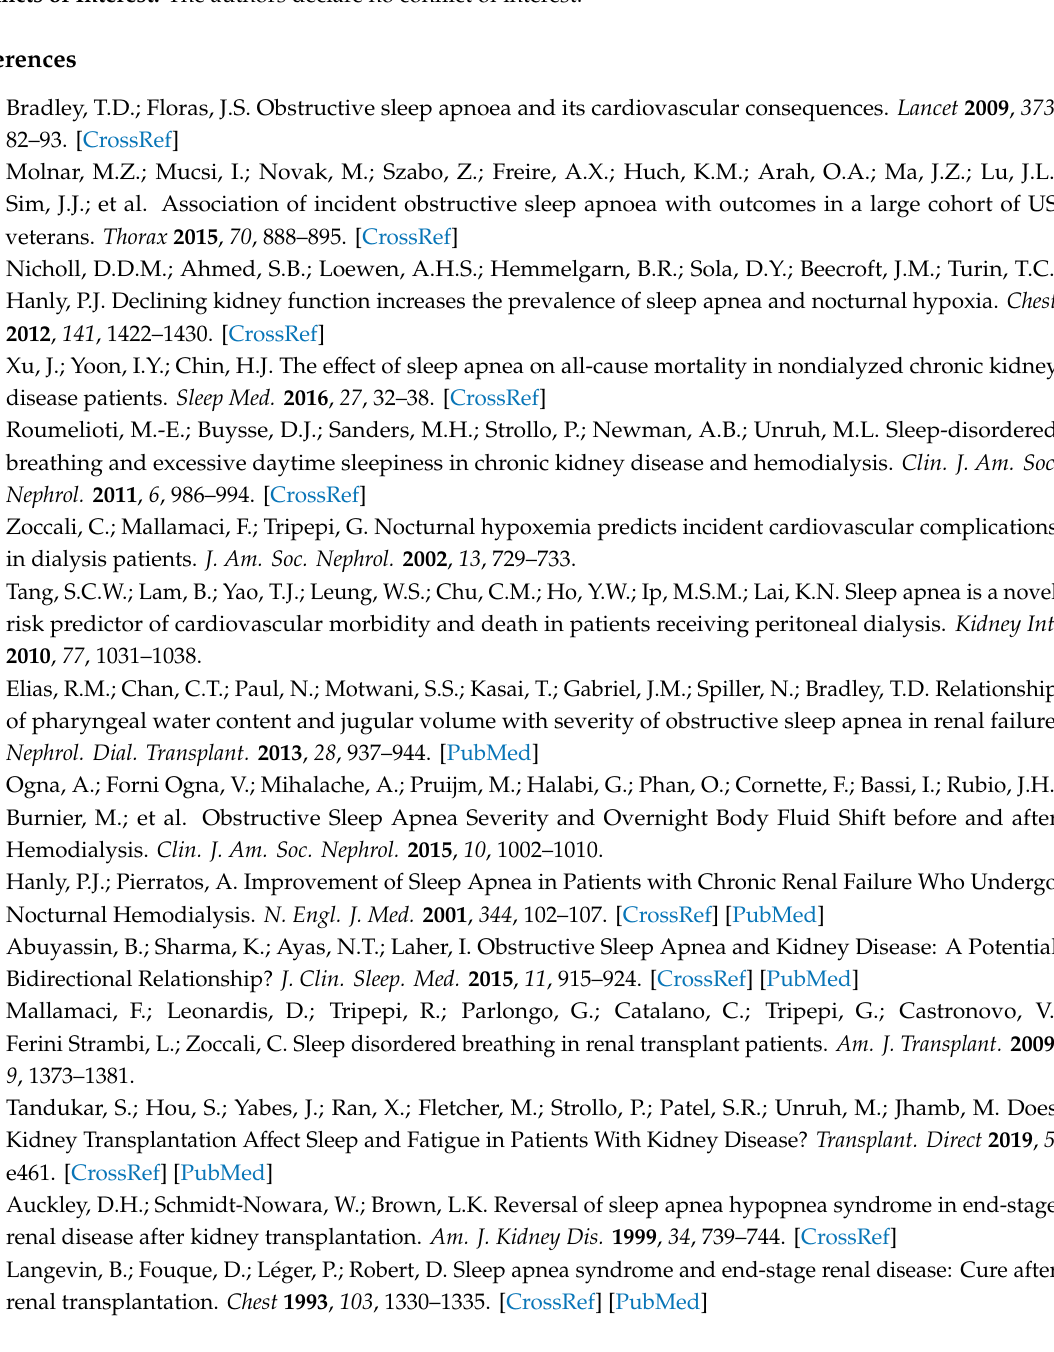
Table S1: Concomitant therapies in the whole study population and in patients divided according to the AHI., Table S2: Adjusted multiple generalized estimating equations (GEE) of AHI and minimal nocturnal O 2 saturation over